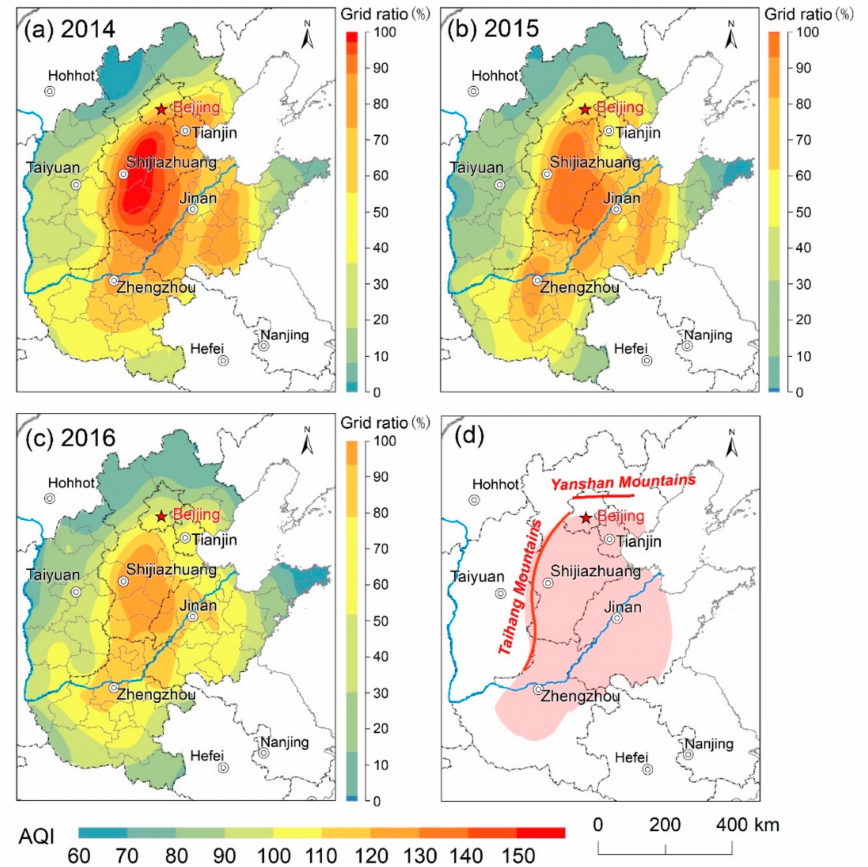
Figure 3. Spatial variation of AQI in North China from 2014 to 2016; ( a – c ) the color bars on the right of each subgraph represent the raster proportion of each AQI interval in each year; ( d ) the core area of air pollution, which was extracted using the Iterative Self-Organizing Data Analysis Technique (ISODATA), located to the south of Yanshan Mountains, west of Taihang Mountains and east of Shandong